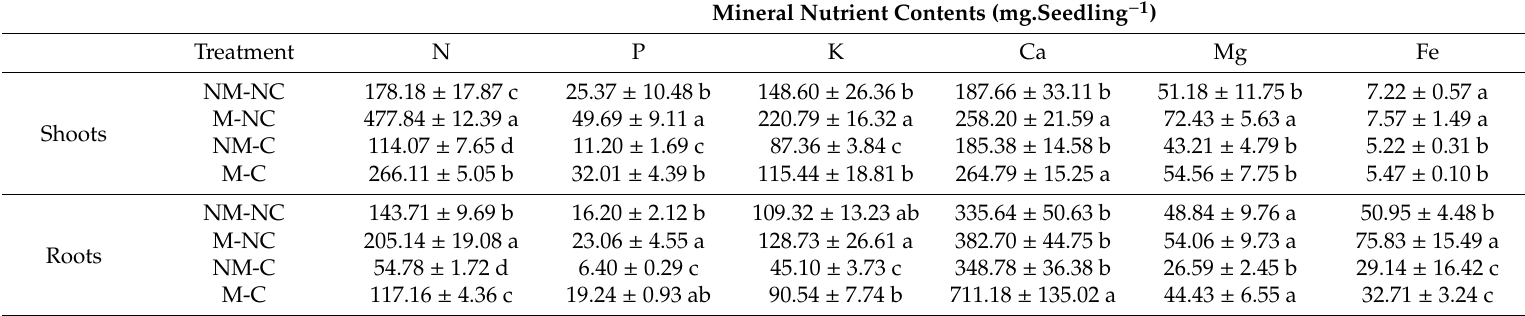
Table 3. Mineral nutrient contents (mg.seedling − 1 ) in shoots and roots of ectomycorrhizal and non-ectomycorrhizal P. halepensis seedlings after 12 months of Pb-Zn-Cd